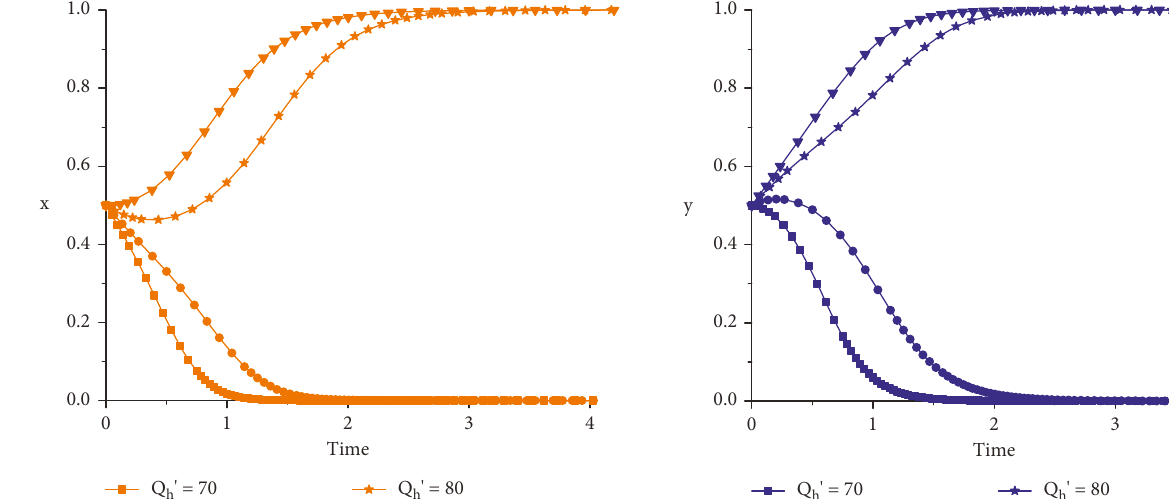
h ′ on enterprise 2.